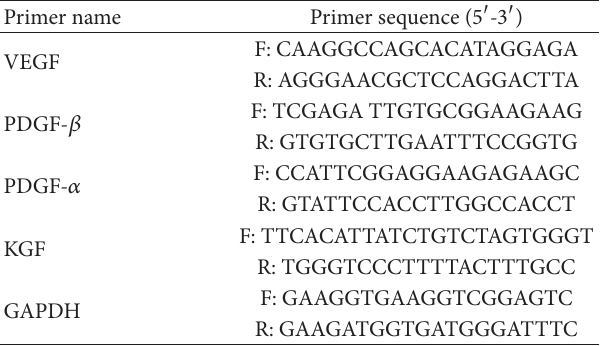
Table 2: Primers used in